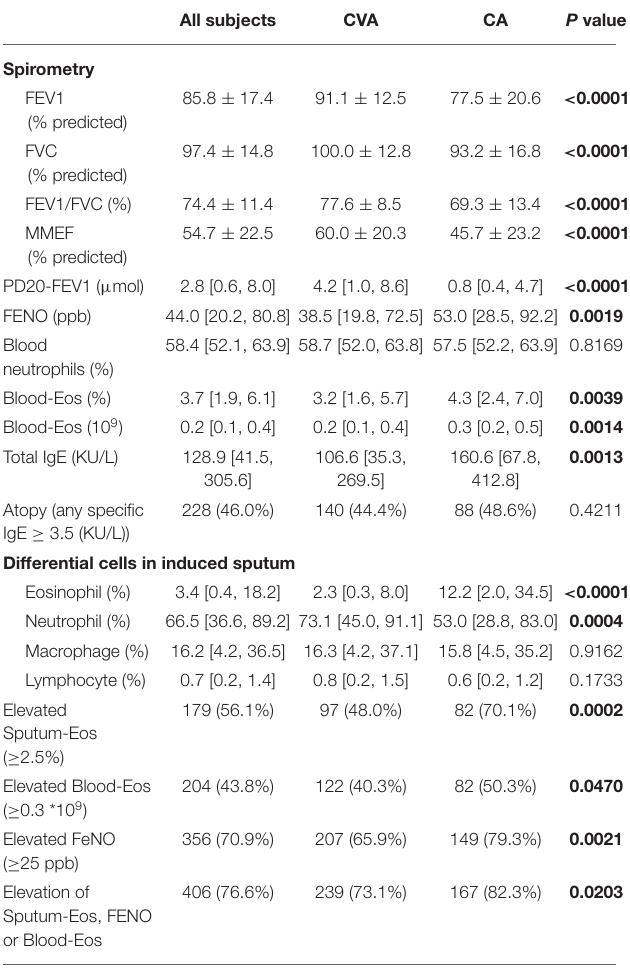
TABLE 4 | Lung function and inflammatory